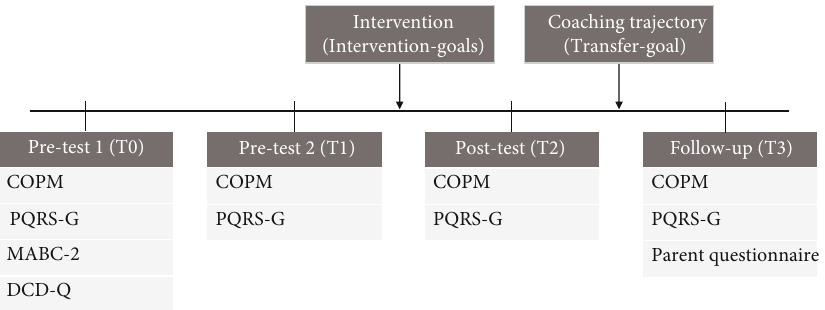
Figure 2: Overview of assessments over time. COPM: Canadian Occupational Performance Measure; PQRS-G: Performance Quality Rating Scale Generic; MABC-2: Movement Assessment Battery for Children 2; DCD-Q: Developmental Coordination Disorder